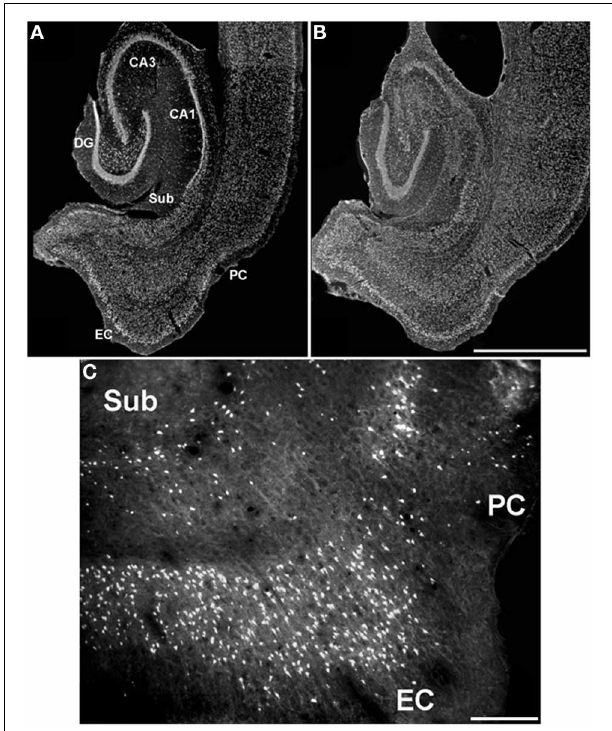
FIGURE 6 | Parvalbumin (PV)-immunopositive interneurons in the rat perirhinal cortex. Photomicrographs showing interneurons stained with an antibody against PV in the perirhinal cortex of 3-week-old rats (A–C) . Specifically, PV immunostaining is shown in a control, non-epileptic rat (A) , and in pilocarpine-treated rats 7 (B) and 14 days (C) after pilocarpine treatment. (D) Normalized (respect to control) quantification of PV immunostained neurons in 3 and 8-week-old rats following pilocarpine treatment. Note in the 3-week-old animals ( n = 3–6 for each time interval) that PV immunostained neurons decrease significantly 3 days as well as 7 and 14 days later. Note that similar findings were observed in 8-week-old rats ( n = 4–5 for each time interval). ∗∗ p < 0 . 01, analysis of variance followed by Tukey’s test for multiple comparisons. Scale bar: 100 μ m. Animal treatment is described in Biagini et al. (2008). Details of the immunostaining procedure and cell counts are in de Guzman et al. (2006, 2008); Bortel et al. (2010) and Benini et al.